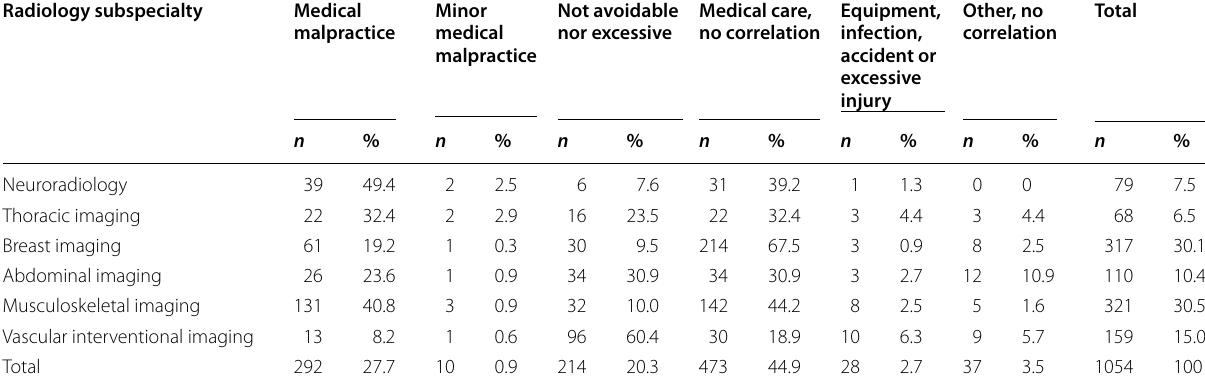
Table 3 Distribution of criteria for compensated (medical malpractice and equipment, infection, accident or excessive injury) and non-compensated decisions in radiology subspecialties